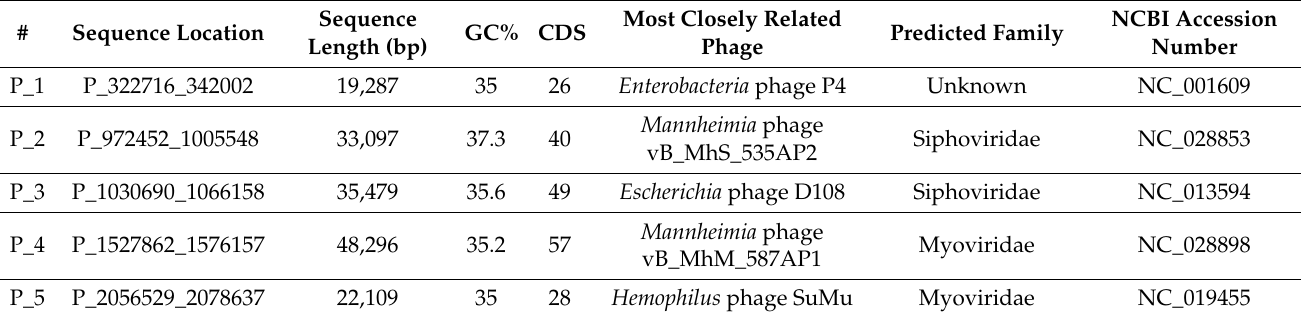
Table 4. Genomic features of the five prophages that were found in the genome of P. atlantica (NVI